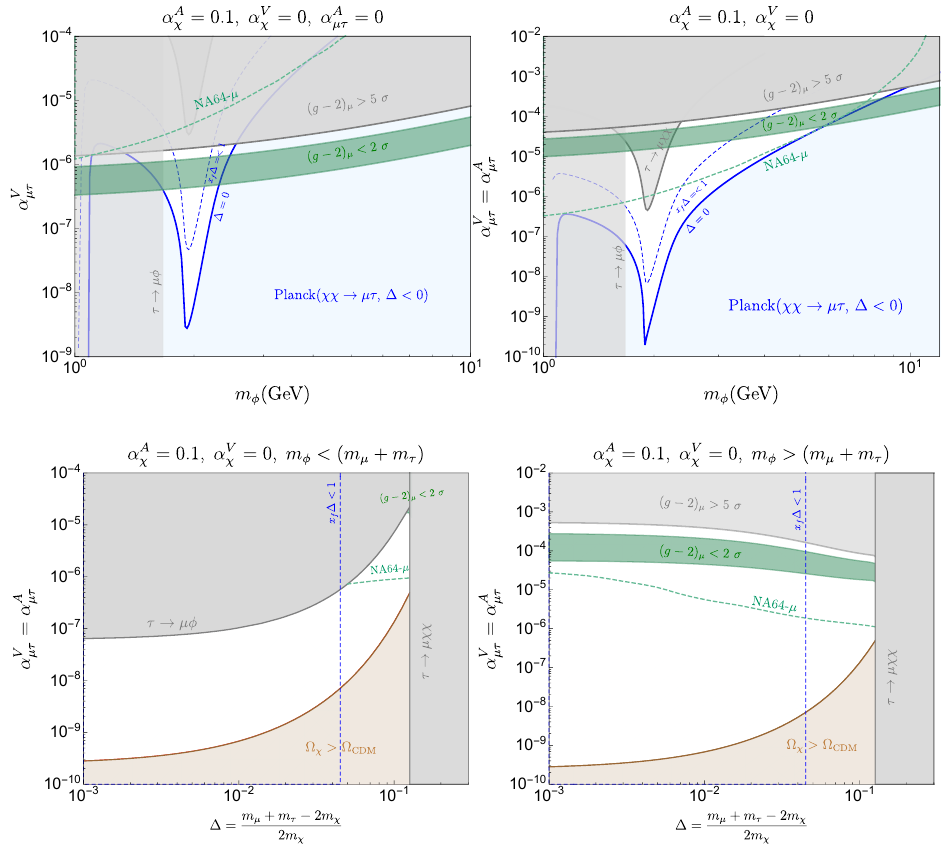
Figure 2 . Theoretical and experimental constraints on Forbidden DM annihilations into τ + µ . We show constraints from measurements of the τ width Γ( τ → µ ¯ ν µ ν τ ) [65], measurements of the muon anomalous magnetic moment [39–41], and Planck constraints on DM annihilations [56]. We include a projection from the future beam-dump experiment NA64- µ [75]. Due to its flavor violating coupling DM is produced at negligible rates at other beam dump experiments listed in the caption of figure 1. In the upper (lower) row, we choose ∆ ( m φ ) to match the observed relic density in the white region. We shade in gray the region where ordinary annihilations into pair of mediators set the relic density. In the brown area Forbidden DM has too large of an